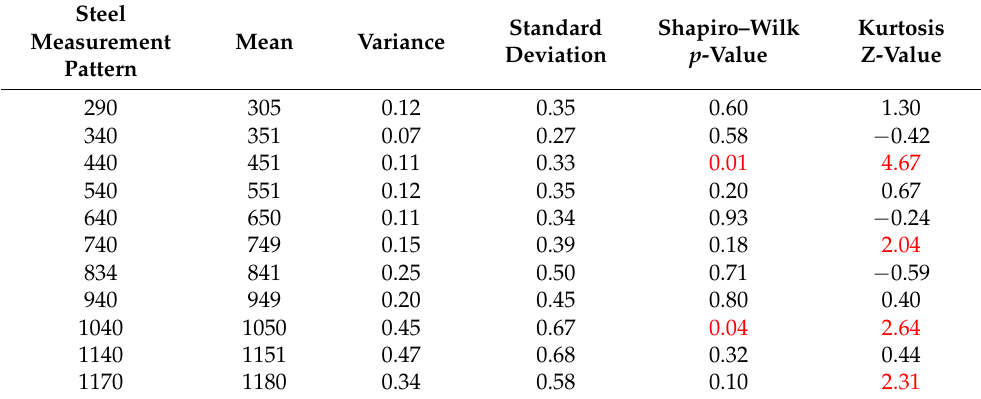
Table 8. Statistical analysis of HC-SR04 values (those written in red do not follow the normal